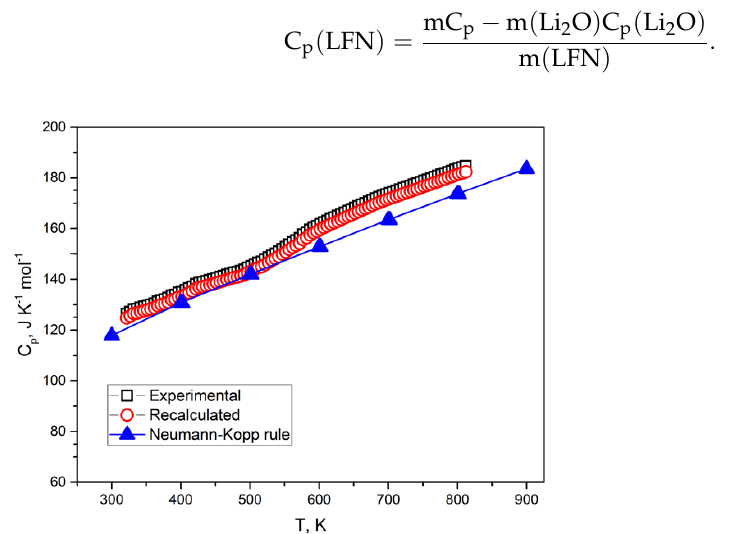
Figure 5. Temperature dependences of the experimental, recalculated, and Neumann–Kopp rule heat capacities of Li 3 FeN 2 . The line for the Neuman–Kopp rule is given as an approximating allometric line.